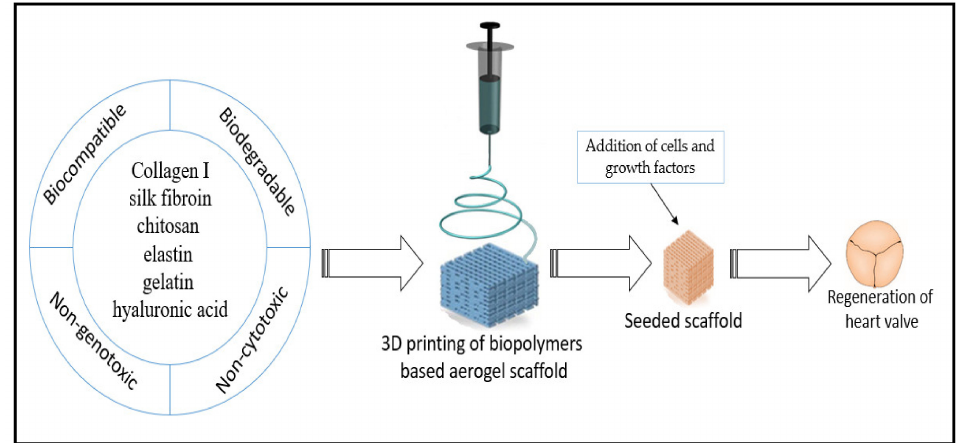
Figure 8. Schematic illustration of heart valve regeneration using biopolymer aerogel-based